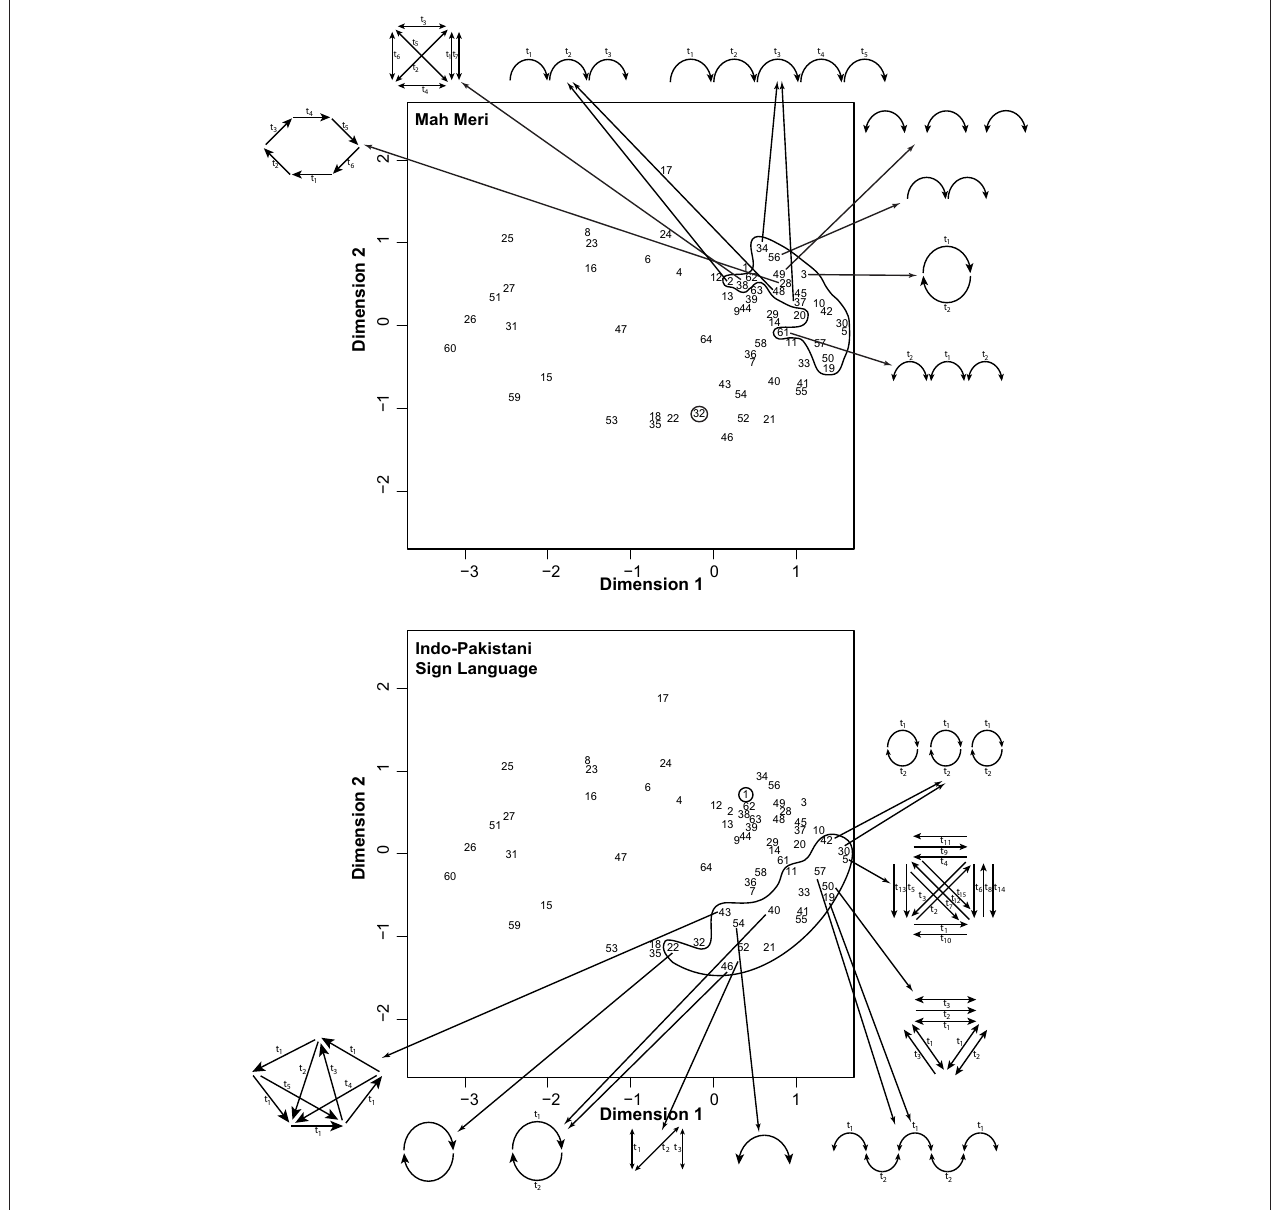
FigurE 8 | Extensional range for Mah Meri (top) and indo-Pakistani Sign Language (bottom) constructions.